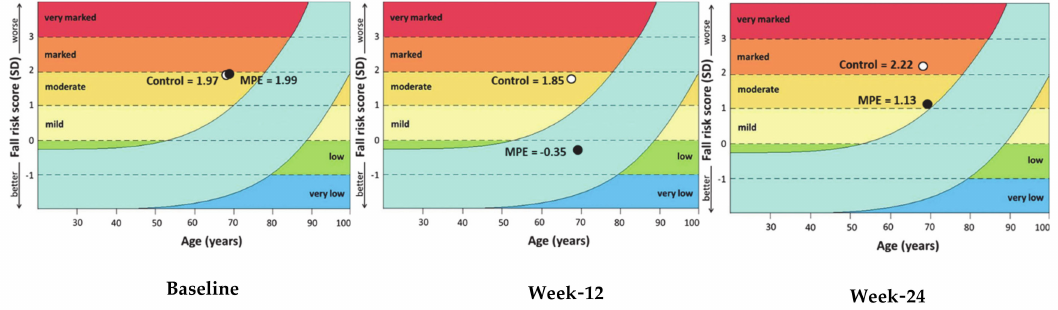
Figure 3. The graphs are defined by the mean fall risk score tested. The X -axis is the average age, and Y -axis is the fall risk. The light blue curved band shows the normal range. The two lines show the 75th percentile (top-line) and the 10th percentile (bottom-line) of the risk of